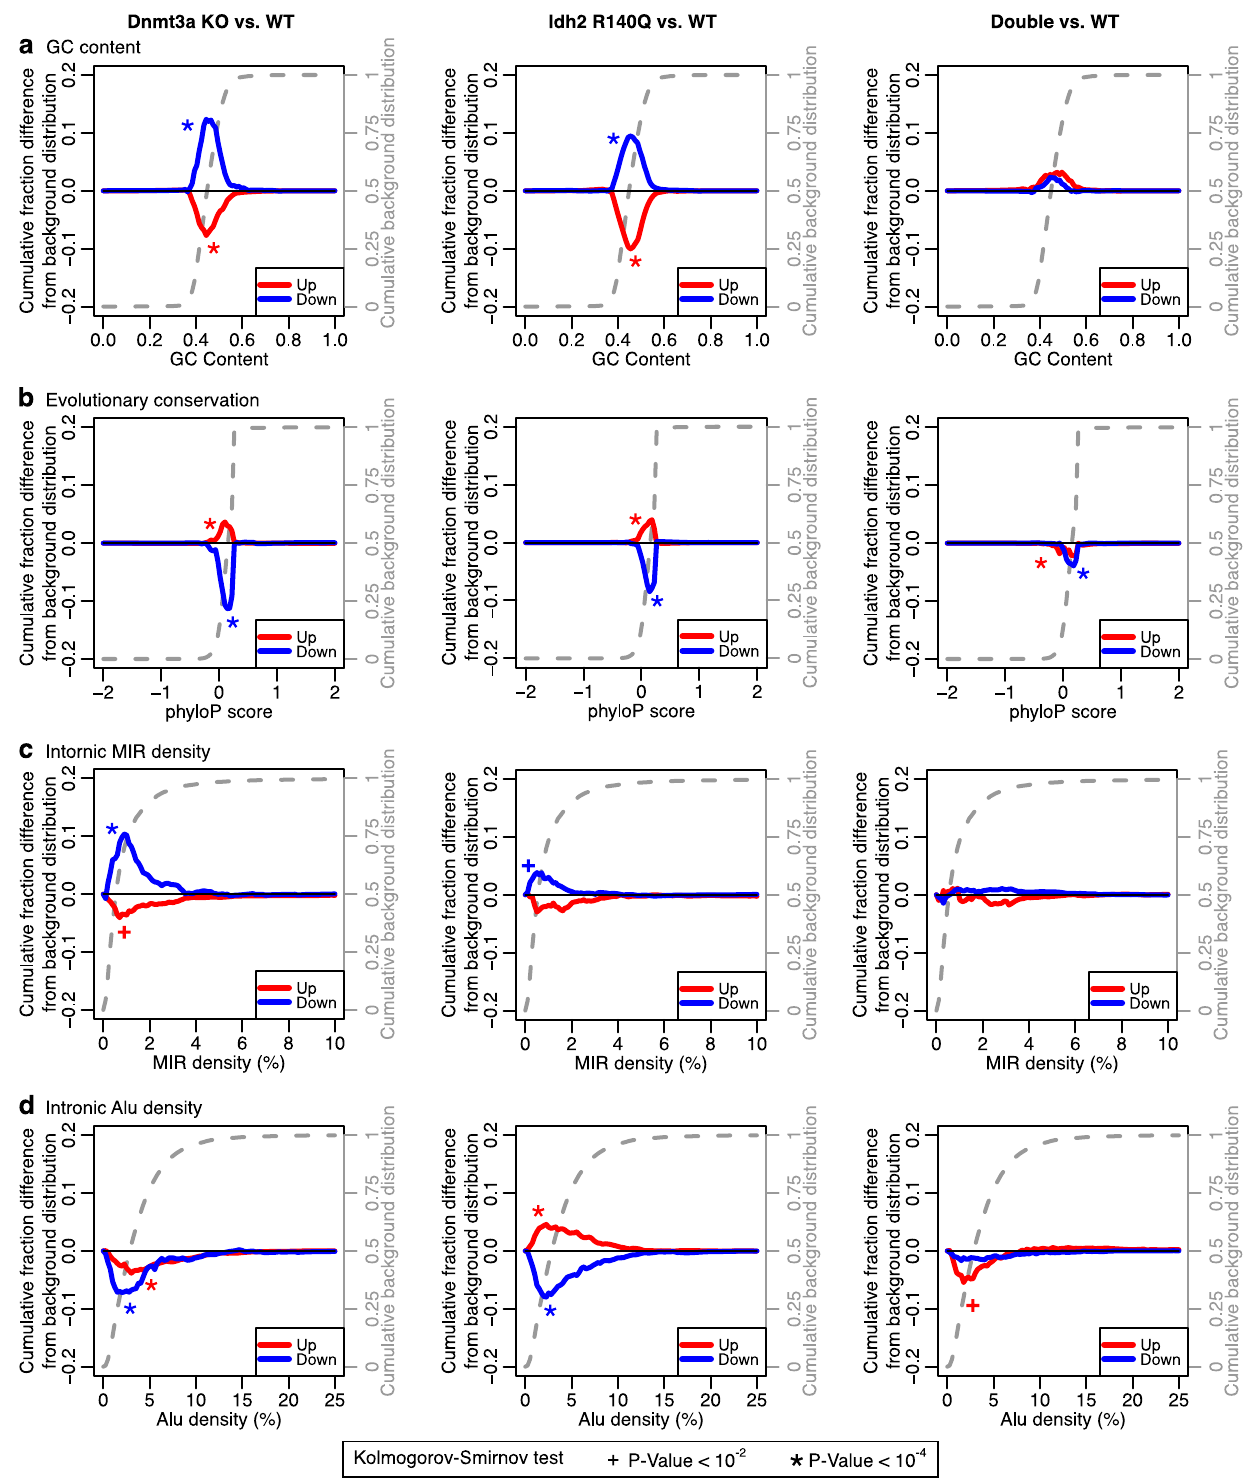
Fig.5|MousemodelsrecapitulatethedependencyofMIR-richgenesonproper Dnmt3a and/or Idh2 function. Differencebetween the cumulative distributionof thebackgroundgenes(dashedgrayline)andthecumulativedistributionoftheup- or downregulated genes after Dnmt3a KO (left column), Idh2 R140Q mutation (middlecolumn)orbothDnmt3aKOandIdh2R140Q(rightcolumn)inGCcontent ( a ), evolutionary conservation ( b ), MIR density ( c ) and Alu density ( d ). Positive